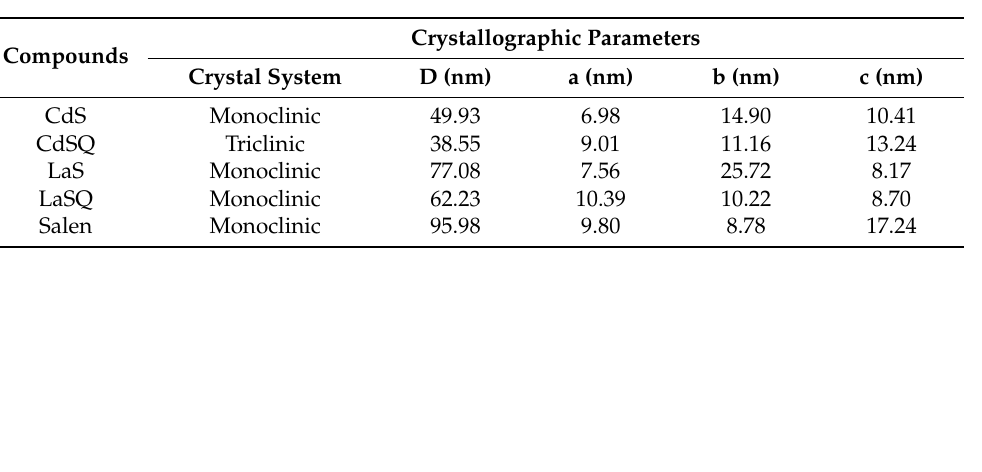
Table 4. PXRD data for salen and mixed-ligand salen/8-hydroxyquinoline metal complexes of Cd(II) and La(III).